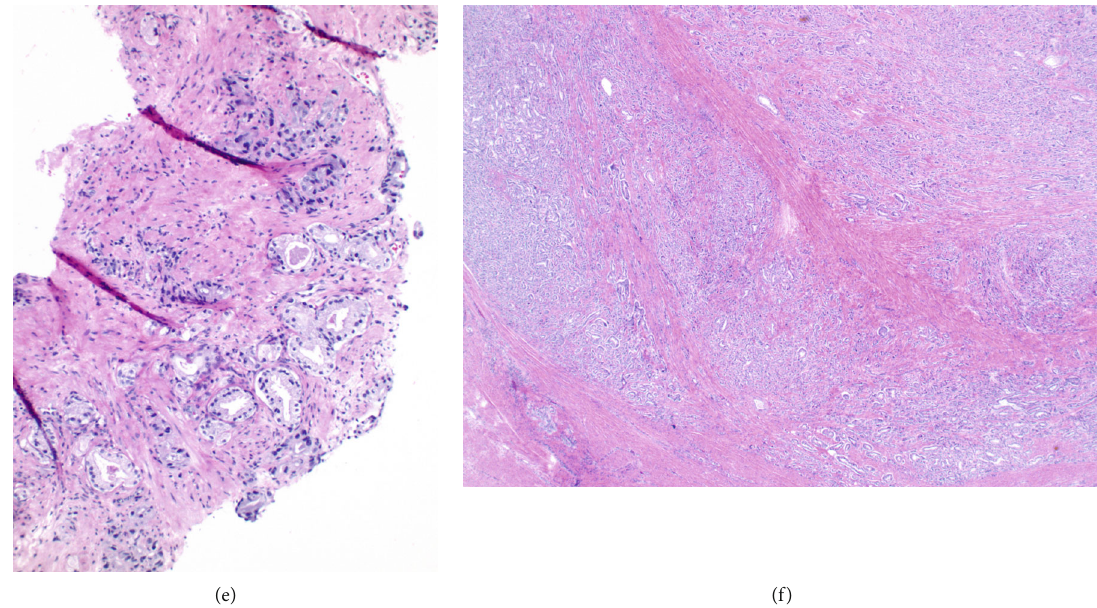
Figure 1: (a) A focus of Gleason GG2 prostatic adenocarcinoma on a targeted core in the 2 nd biopsy; (b) T2-weighted image shows lenticular homogeneous moderately hypointense lesion (arrow) measuring 1.5cm located in right anterior transitional zone in midgland, representative of Prostate Imaging Reporting and Data System category 5; (c) apparent di ff usion coe ffi cient map shows marked focal hypointensity (arrow); (d) a single focus of Gleason GG4 prostatic adenocarcinoma on a systematic core in the 3 rd biopsy; (e) in fi ltrative growth of Gleason GG3 prostatic adenocarcinoma on a systematic core in the 3 rd biopsy. Gleason pattern 3 is comprised of well-formed glands with relatively clear cytoplasm, small nuclei, and inconspicuous nucleoli. Gleason pattern 4 is made up of smaller, poorly formed glands with amphophilic cytoplasm, larger nuclei, and variably prominent nucleoli; (f) a radical prostatectomy specimen showing two distinct patterns of prostatic adenocarcinoma (the majority of Gleason pattern 3 and small population of pattern 4). Table 1: Biomarker measures during active